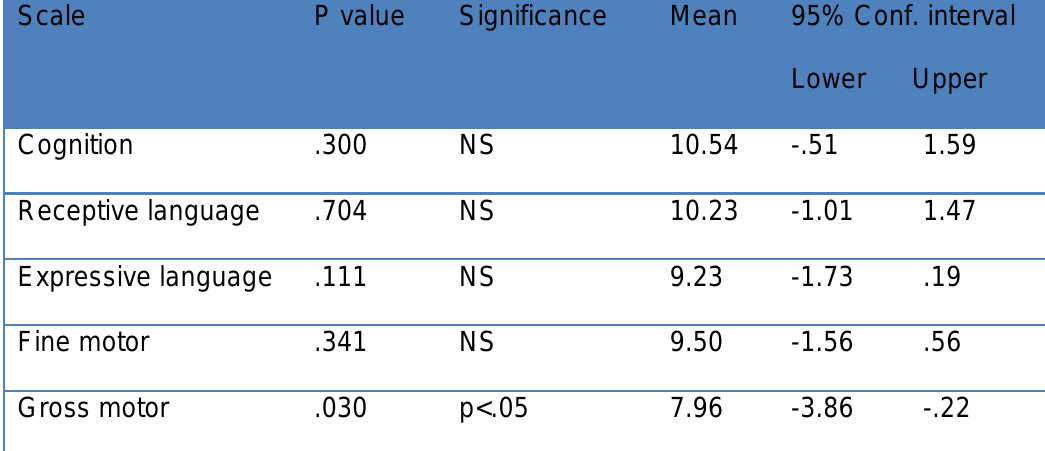
Table 3: Developmental assessment at 1 year of age (3 year cohort)